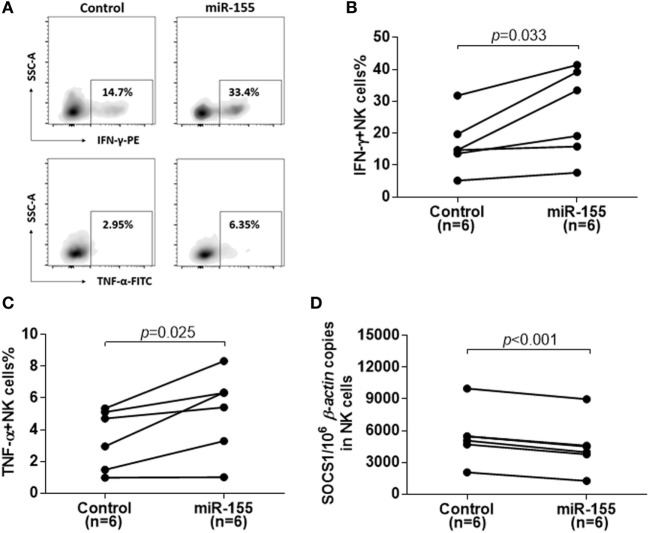
Reconstitution of miR-155 in natural killer (NK) cells from immune-activation (IA) patients led to decreases in suppressor of cytokine signaling 1 (SOCS1) expression and increases in cytokine production. Purity of NK cells from IA patients was transfection with miR-control or miR-155-mimic for 72 h. (A–C) After stimulated with IL-12 (10 ng/ml), IL-15 (10 ng/ml), and IL-18 (100 ng/ml) for 24 h, IFN-γ and TNF-α secretion of isolated NK cells were detected by flow cytometric analysis. A representative pattern (A) and statistics analysis of IFN-γ (B) and TNF-α (C) secretion of transfected NK cells determined by flow cytometric analysis. (D) After 72 h transfection, SOCS1 mRNA expression in isolated NK cells was determined by real-time RT-PCR. Control, miR-control; miR-155, miR-155 mimic.